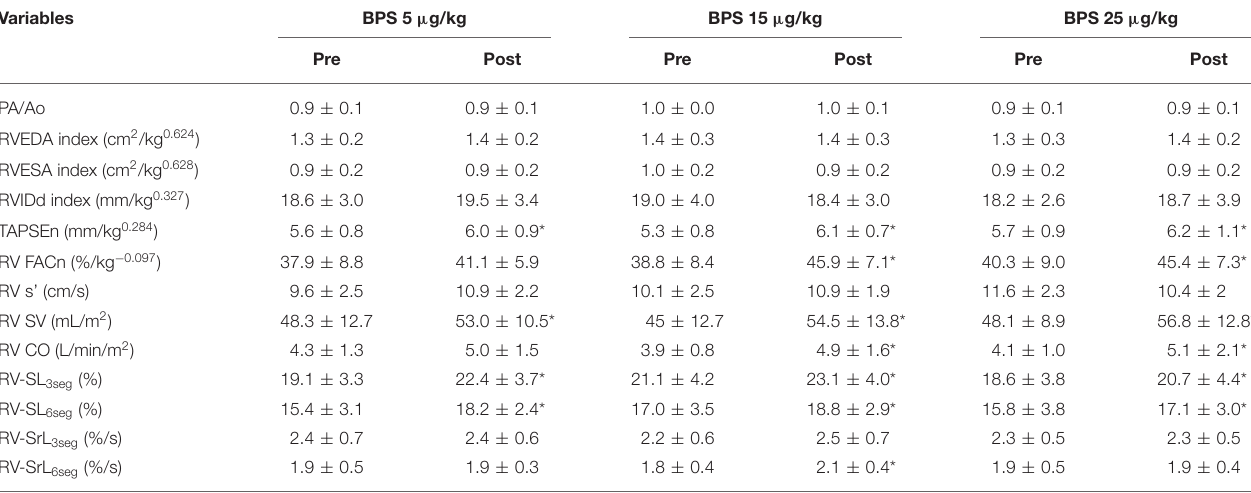
TABLE 4 | Changes in echocardiographic parameters for right heart morphology and function before and after beraprost sodium administration.